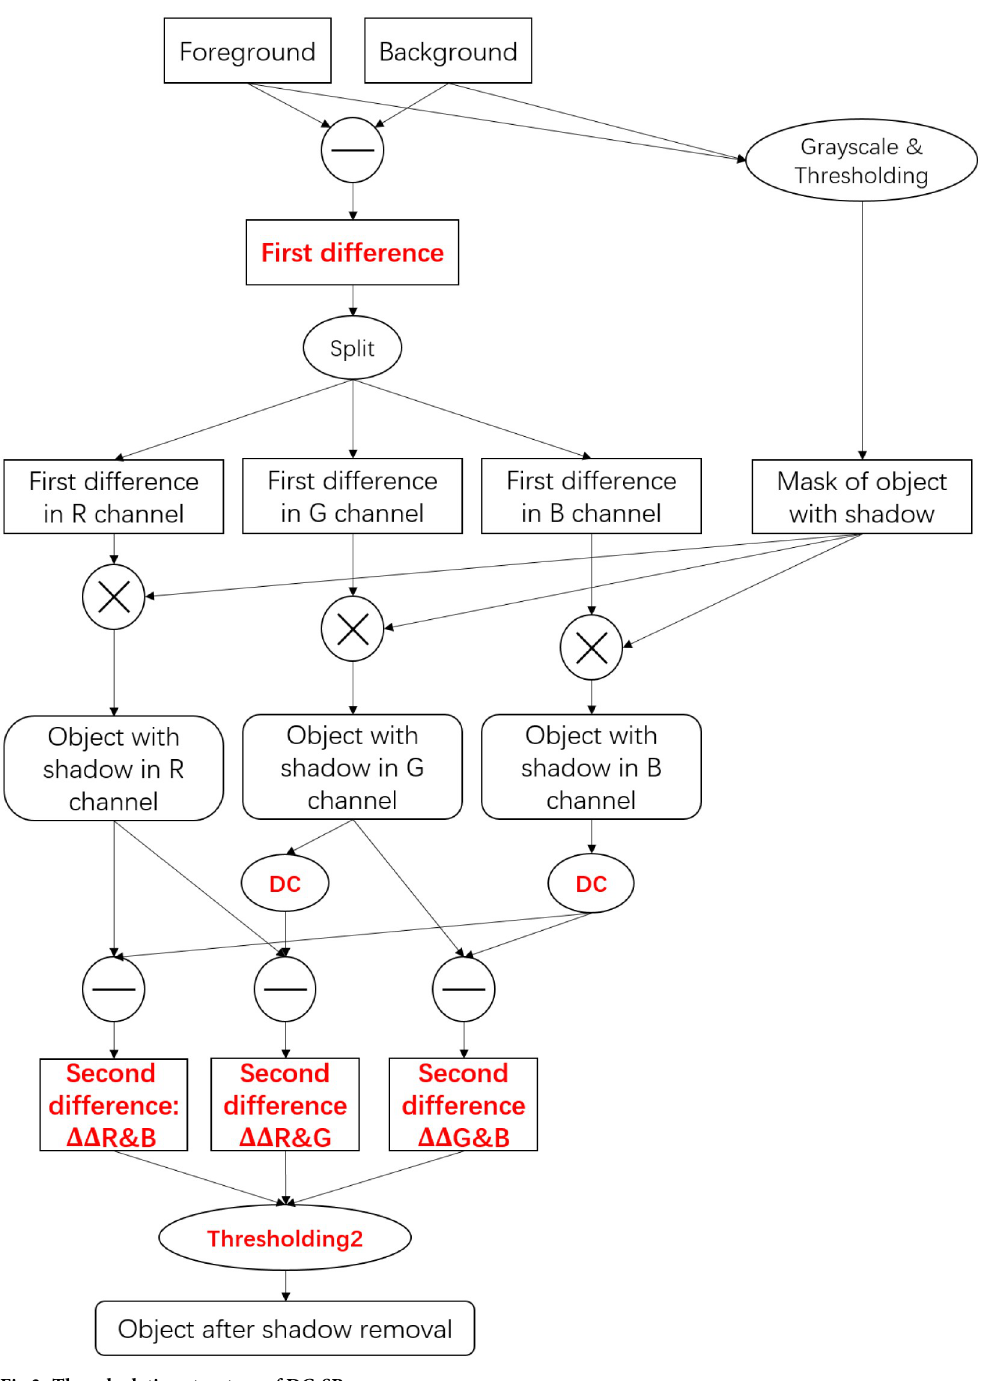
Fig 3. The calculation structure of DC-SR.